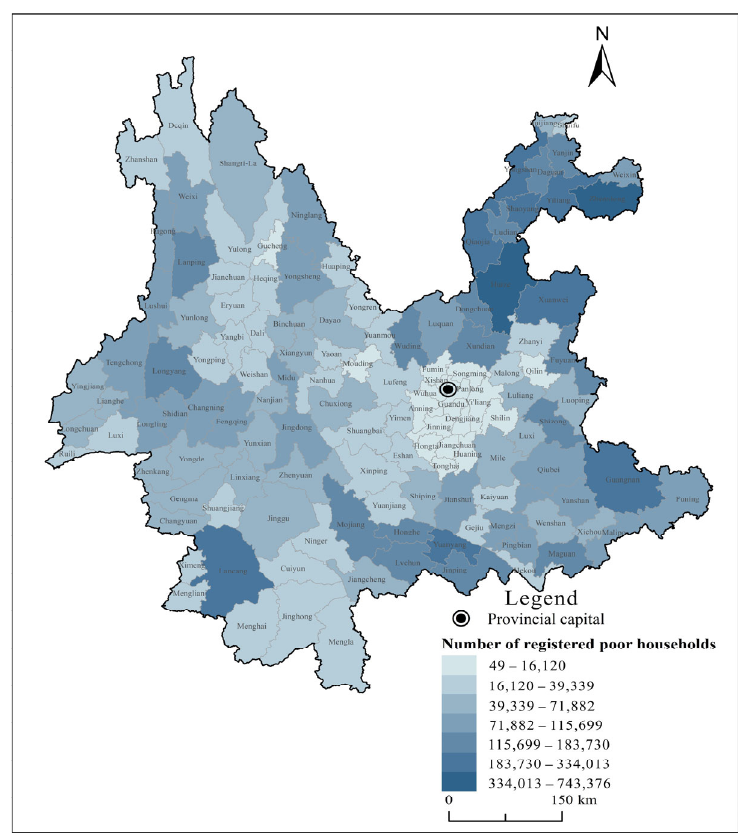
Figure 1. Distribution of CDAs and poor counties in Yunnan in 2020.